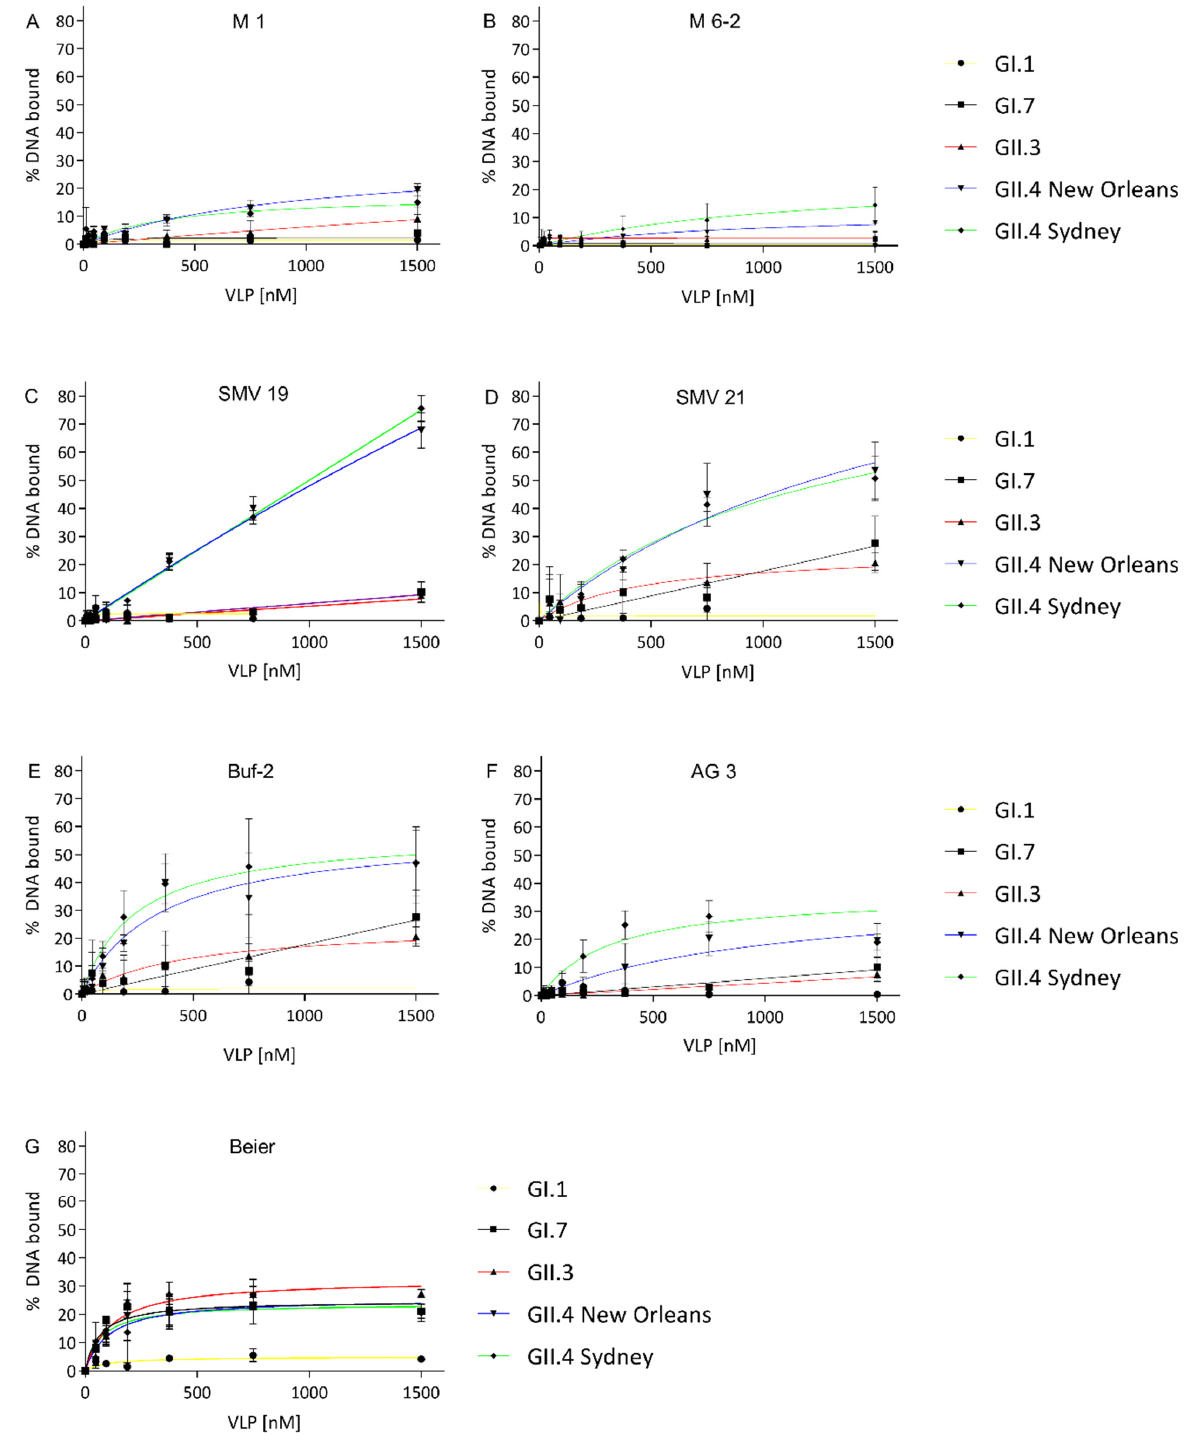
Figure 1. VLP-binding graphs of aptamers M1 ( A ), M6-2 ( B ), SMV19 ( C ), SMV21 ( D ), Buf-2 ( E ), AG3 ( F ) and Beier ( G ). The different curves represent the NoV VLP genotypes GI.1 (yellow), GI.7 (black), GII.3 (red), GII.4 New Orleans (blue), and GII.4 Sydney (green). All graphs are shown with the y-axes indicating bound DNA to target protein from 0 to 80% to allow uniform evaluation of the graphs.